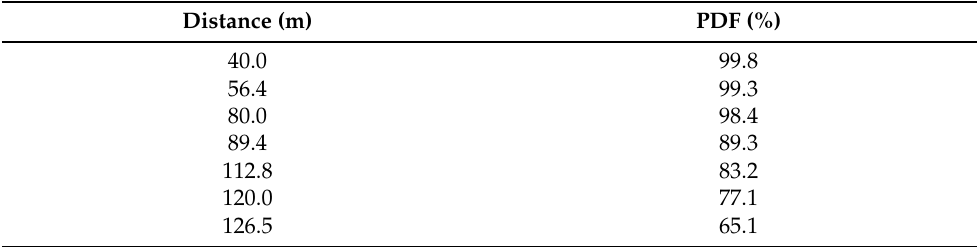
Table 2. Packet delivery fraction (PDF) on a single hop measured against light background